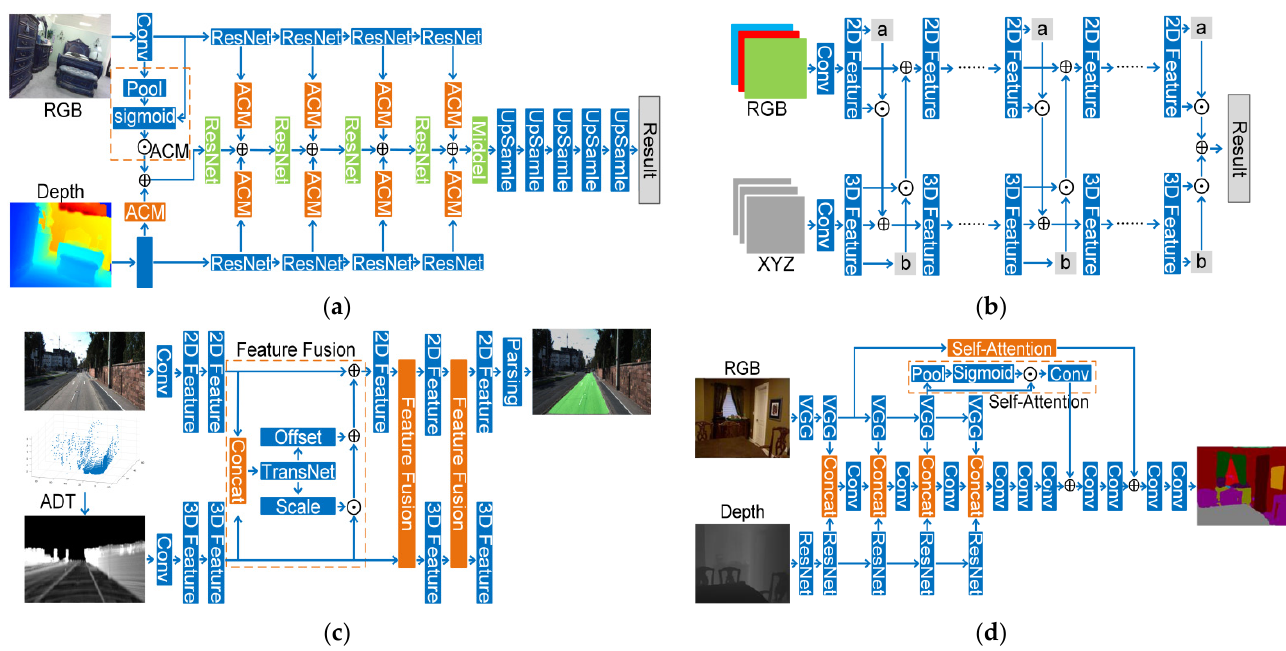
Figure 5. The representative segmentation methods using cross-level feature-based fusion strategy. ( a ) ACNet; ( b ) The method with cross fusion strategy; ( c ) PLARD; ( d )